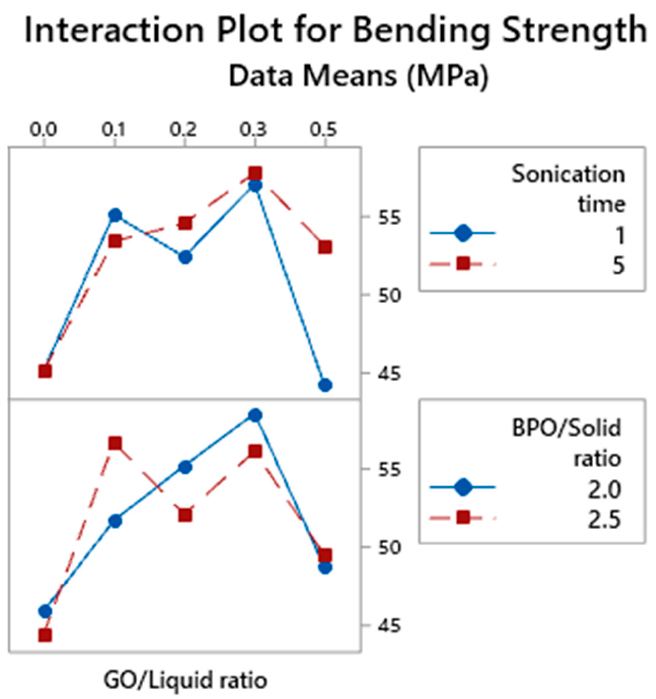
Figure 8. Interaction plot between the effect sonication time vs. GO/liquid ratio and BPO/solid ratio vs. GO/liquid ratio for the variable bending strength.